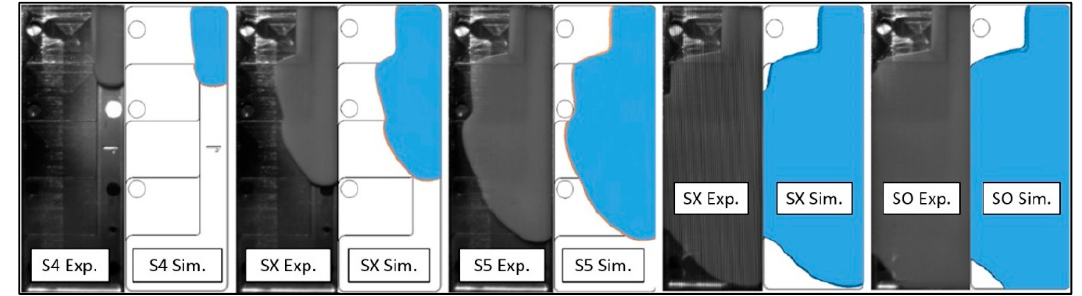
Figure 10. Visual Comparison between experimental and simulated flow front of ComM-C1. The gate position is located at the top right of each image.